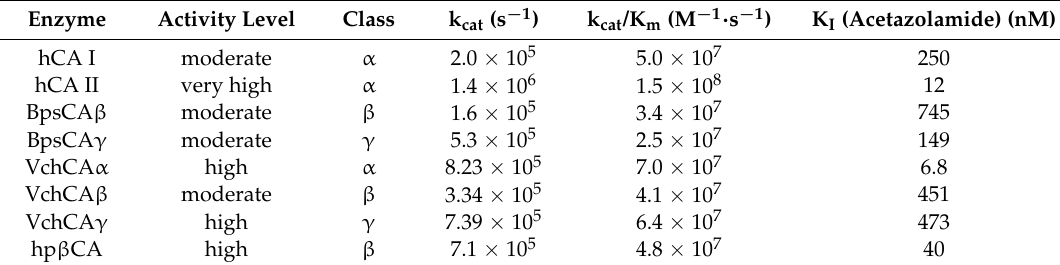
Table 2. Kinetic parameters for the CO 2 hydration reaction catalysed by the human cytosolic isozymes hCA I and II ( α -class CAs) at 20 ◦ C and pH 7.5 in 10 mM HEPES buffer and 20 mM Na 2 SO 4 , β - and γ -CAs from B. pseudomallei measured at 20 ◦ C, pH 8.3 in 20 mM TRIS buffer and 20 mM NaClO β -, and γ -CAs from Vibrio cholerae [8,49,50], and β -CA from Helicobacter pylori [36,51,52]. Acetazolamide inhibition data are also